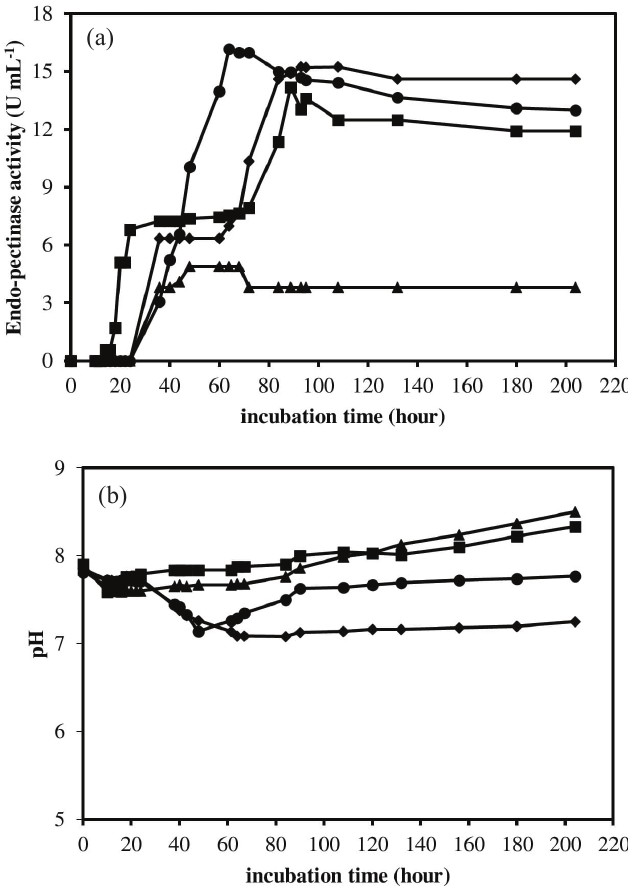
Fig. 3 – a) Effect of different carbon sources on endo-pecti- nase production by Bacillus pumilus NRRL B-212, b) change in medium pH over time at different carbon sources (pH= 8, T: 30 °C, agitation rate: 150 rpm, ♦: 1 % (w/v) glucose, ■: 1 % (w/v) polygalacturonic acid, ▲ : 2 % (w/v) polygalacturonic acid, ●: 1 % (w/v)